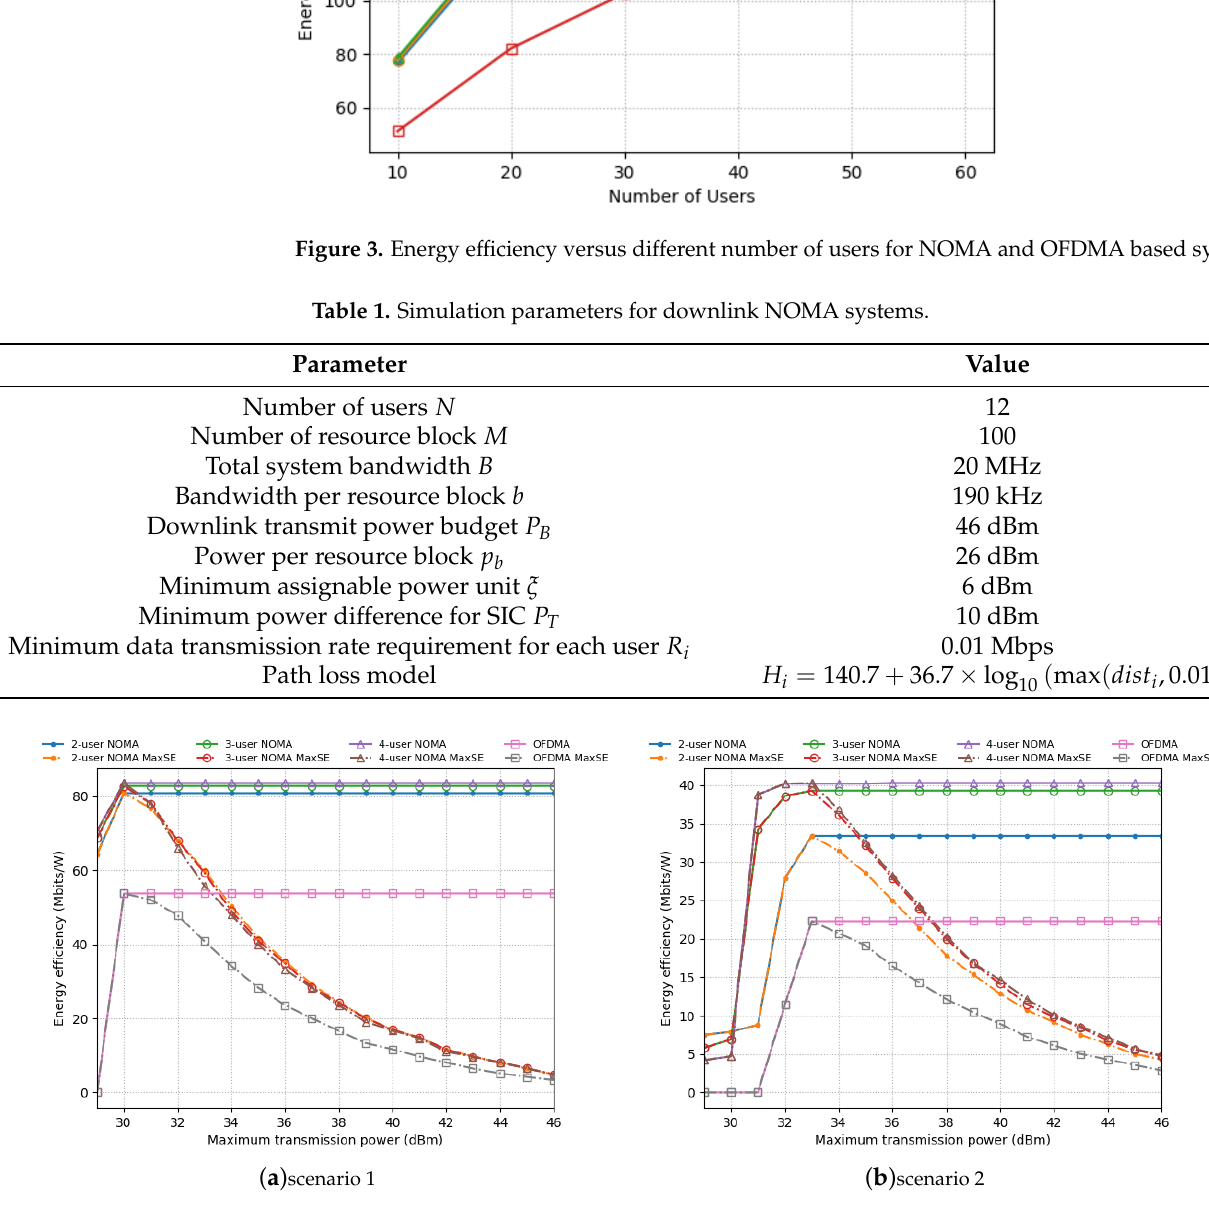
Figure 4. Energy efficiency versus maximum transmission power of BS for NOMA systems equipped with the proposed user clustering and power allocation methods and OFDMA based